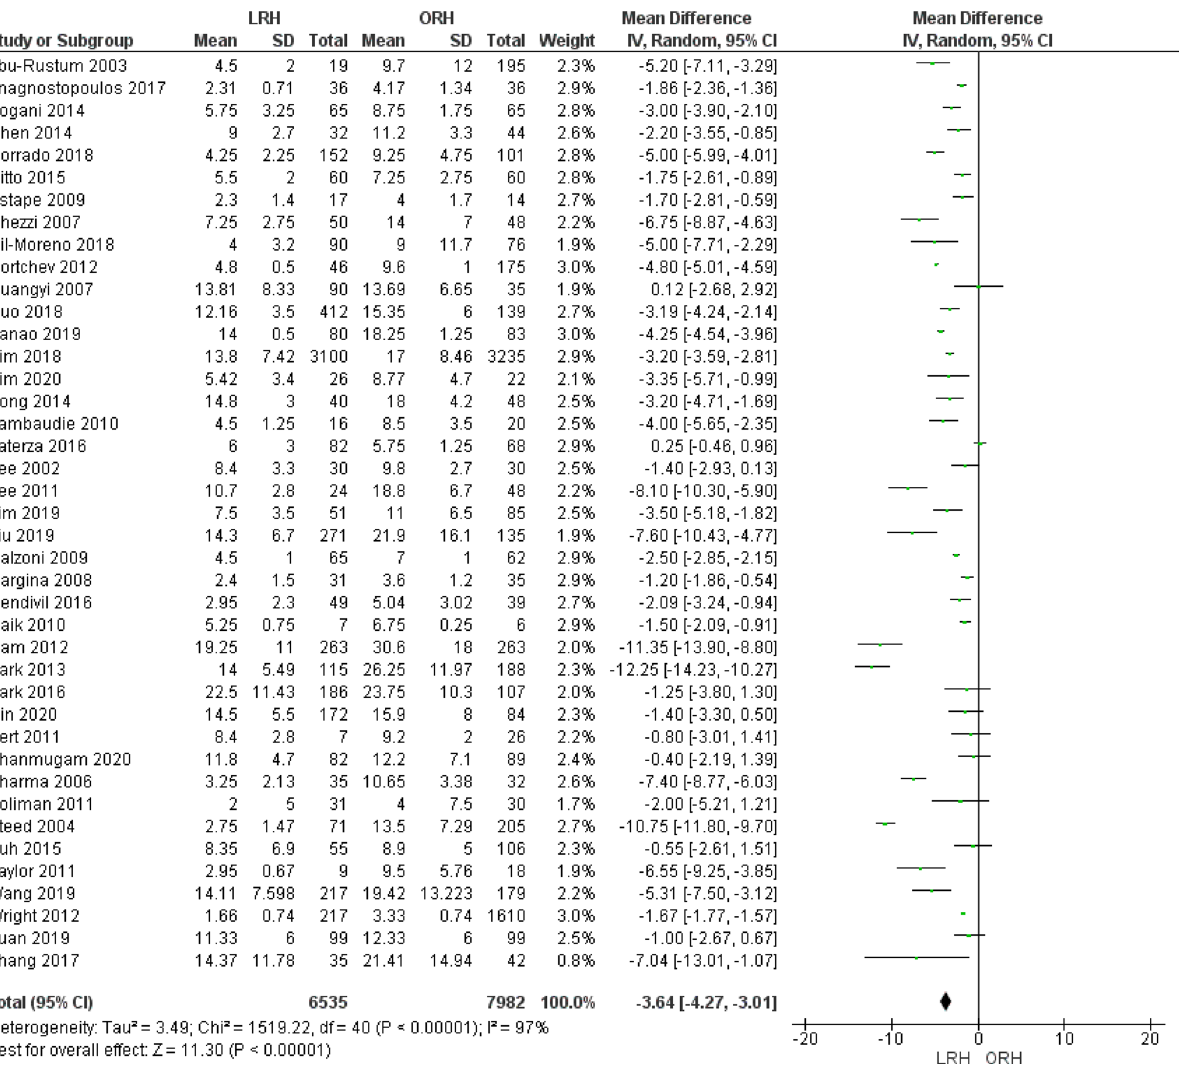
Figure 6. Forest plot of the average length of hospital